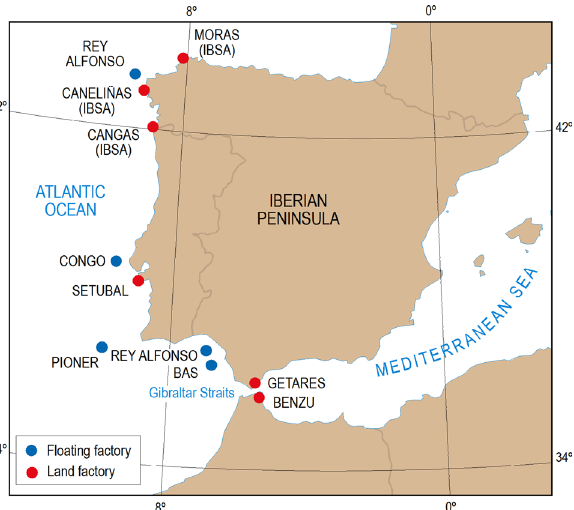
Figure 1. Location of the whaling stations that operated around the Iberian Peninsula. Figure generated by Albert Martinez with the program Freehand